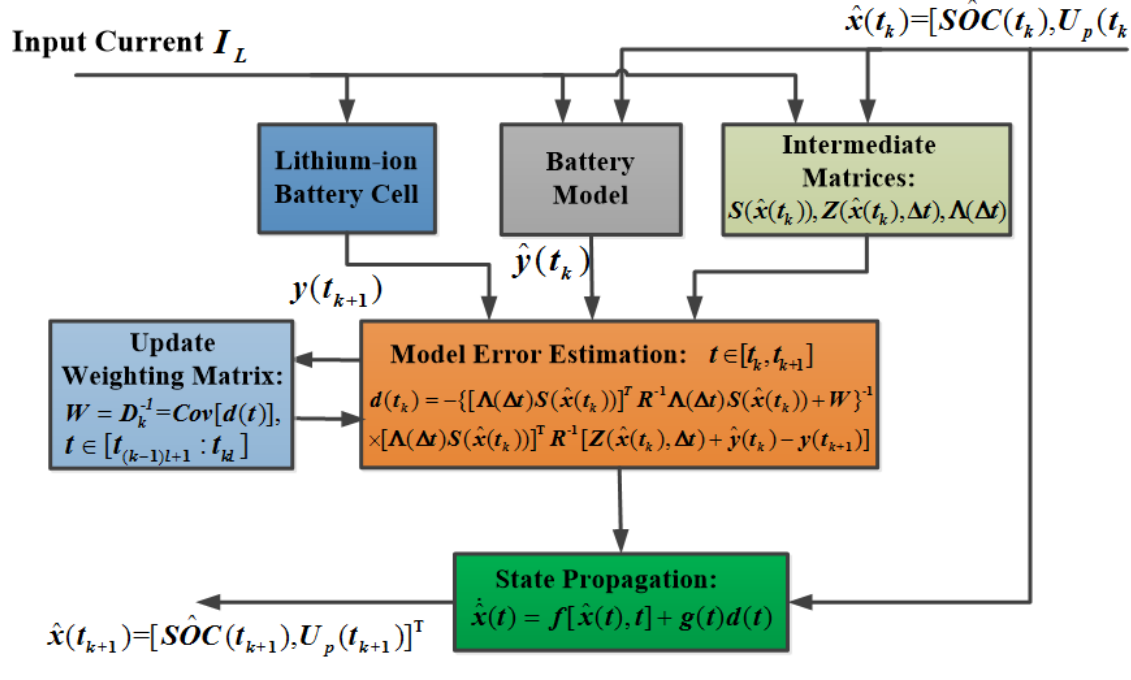
Figure 8. Schematic diagram of NPF based SOC